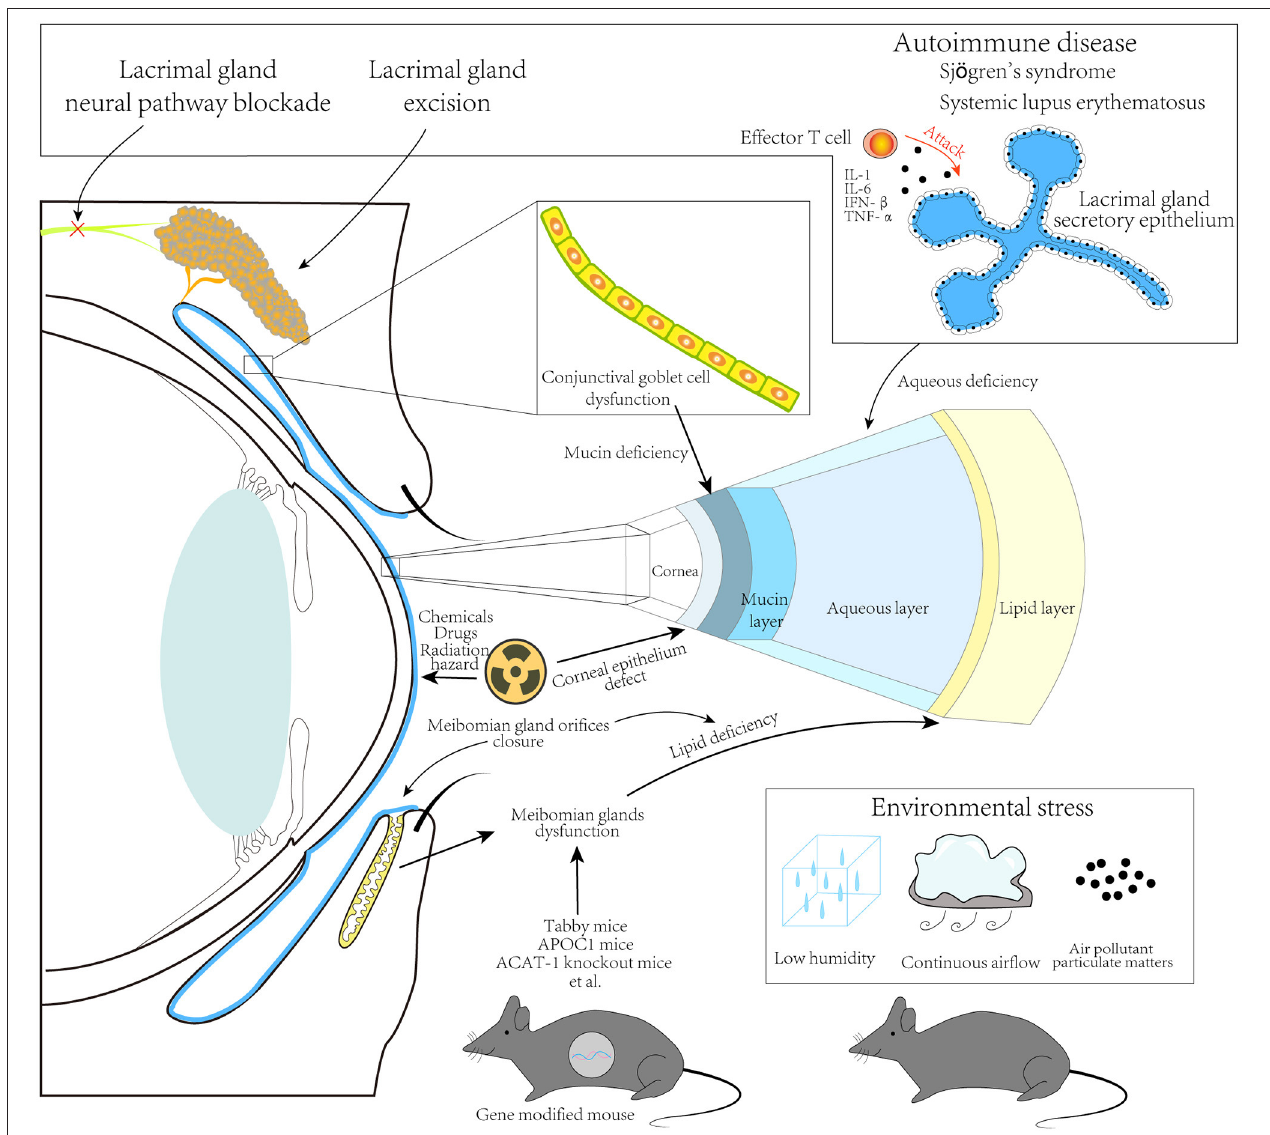
FIGURE 1 | Principles for animal dry eye modeling. A schematic showing approaches to developing animal dry eye models, including major methods used in recently published studies, as described in this review. Lacrimal glands excision, neural pathway blocking, and autoimmune disease models, including Sjögren’s syndrome and systemic lupus erythematosus, have been developed by targeting the lacrimal gland. These result in an aqueous deficiency in the tear film. Conjunctival goblet cell damage can result in mucin deficiency in the tear film. Further, chemicals, drugs, and radiation hazards mainly cause corneal epithelium damage. Some gene-modified mice can present with dysfunction or direct damage of the Meibomian glands, resulting in lipid deficiency in the tear film. Environmental stress due to changing humidity, controlling airflow, and/or introduction of air pollution particulate matter, could also be significant in animal dry eye